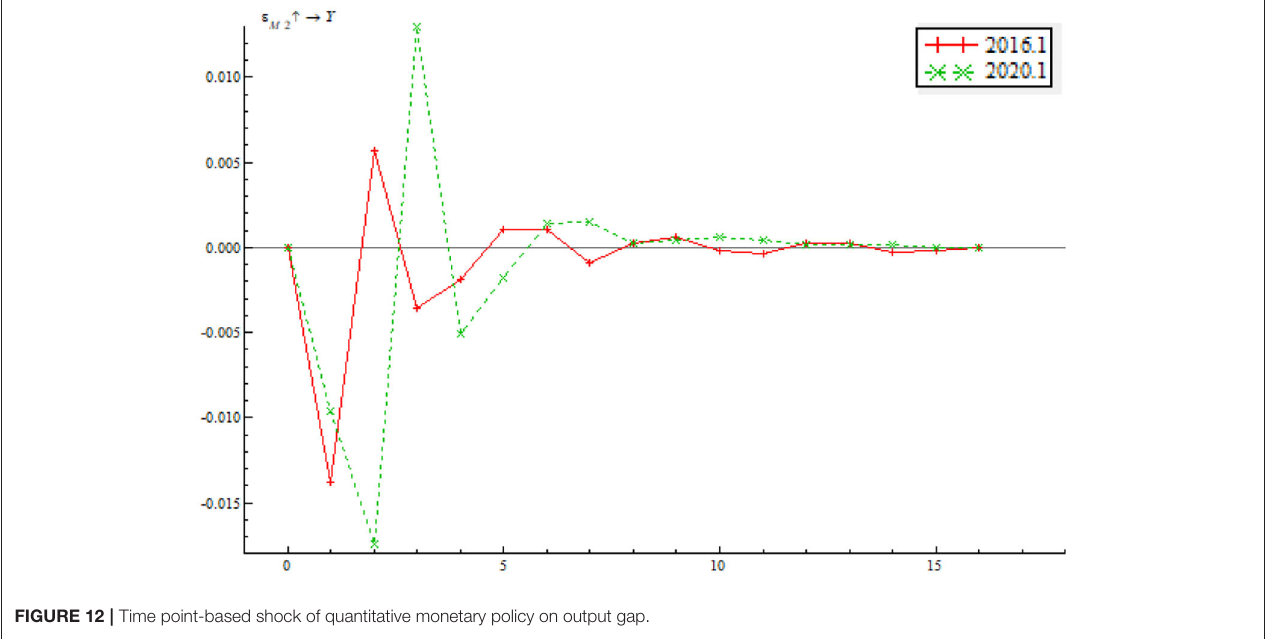
FIGURE 12 | Time point-based shock of quantitative monetary policy on output gap.